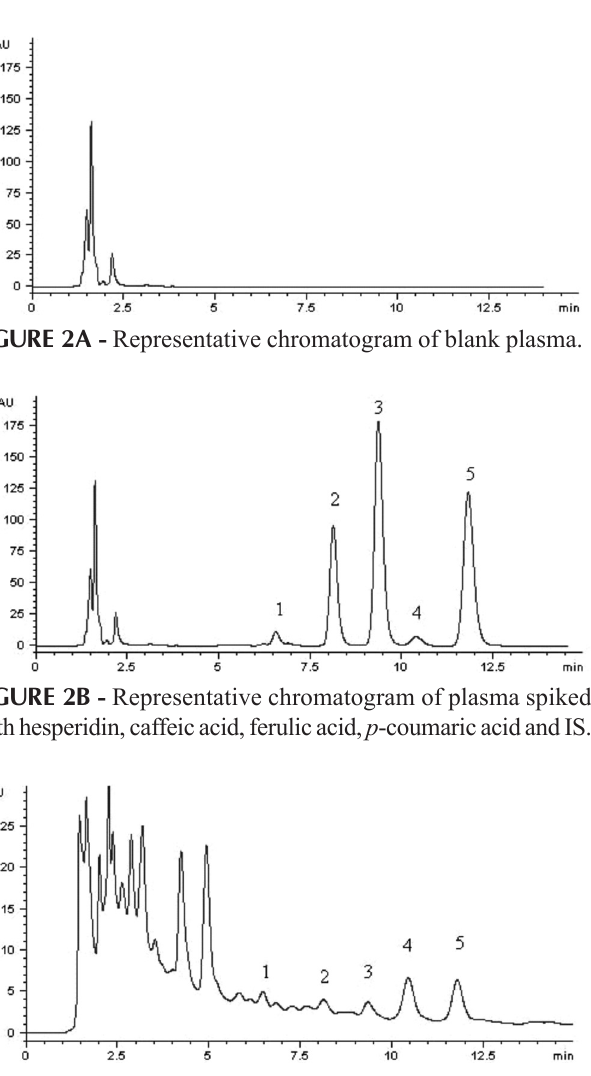
FIGURE 2C - Representative chromatogram of plasma sample after 5 min intravenous administration of